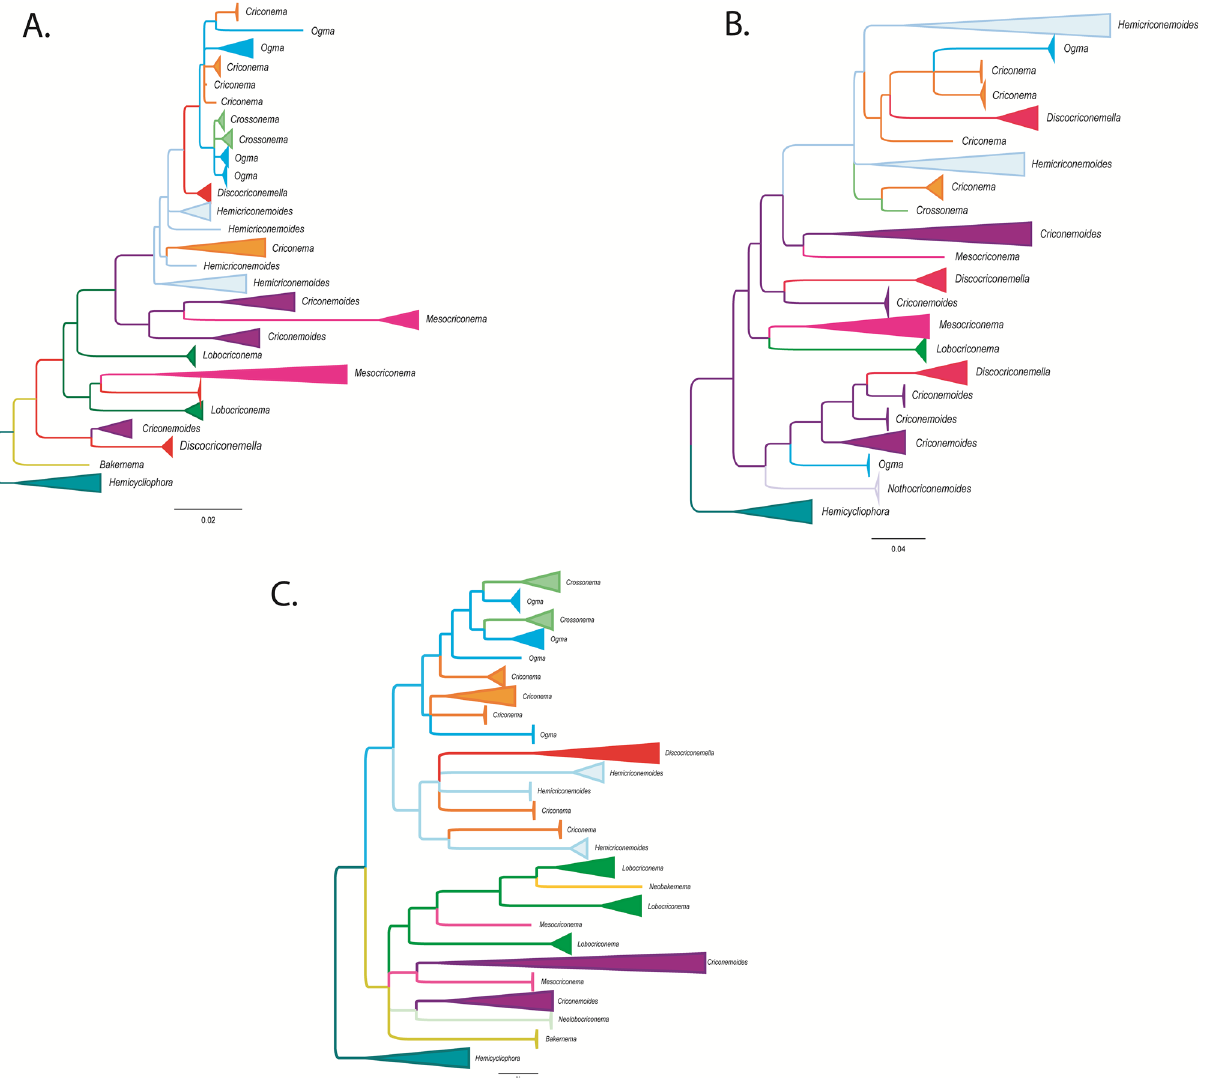
Figure 6. Simplified phylogenetic trees showing relationships between genera in Criconematidae in this study. ( A ) 18S tree; ( B ) D2-D3 tree; ( C ) COI